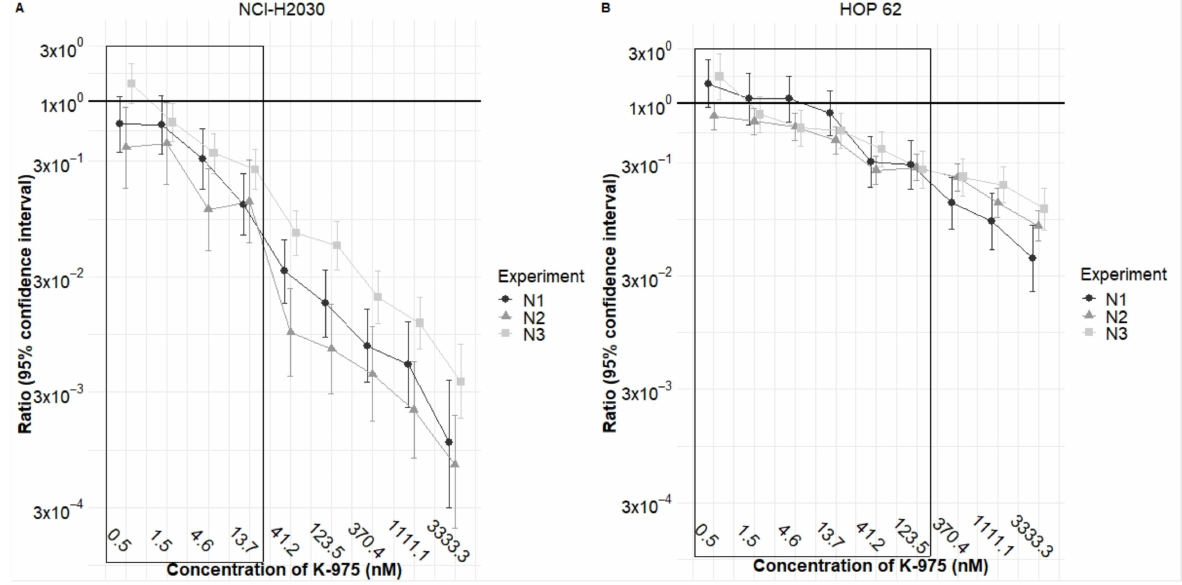
Figure 2. K-975 potentiates adagrasib in HOP 62 and NCI-H2030 cell lines. This graph shows the ratio values obtained for adagrasib either as a single agent or combined with increasing concentrations of the K-975 inhibitor. ( A ) Confirmatory study with the NCI-H2030 cell line shows the potentiation effect that is statistically evident for the four concentrations at which K-975 is entirely inactive as a single agent. ( B ) Confirmatory study with the HOP 62 cell line shows the potentiation effect that is statistically evident for six concentrations at which K-975 is entirely inactive as a single agent. The boxed values in panels A and B show the ratio of the potentiation effect of adagrasib when K-975 is used at doses where it is completely inactive as a single agent. Geometric means and SD were calculated for three independent experiments (N1, N2,